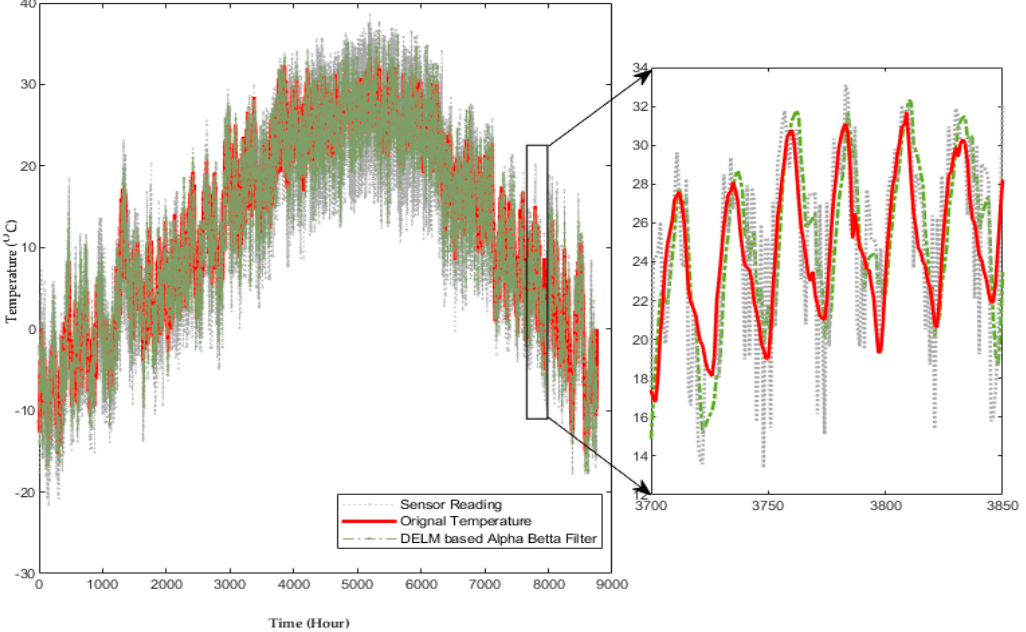
Figure 9. The deep-extreme-learning-machine-based alpha-beta filter results.